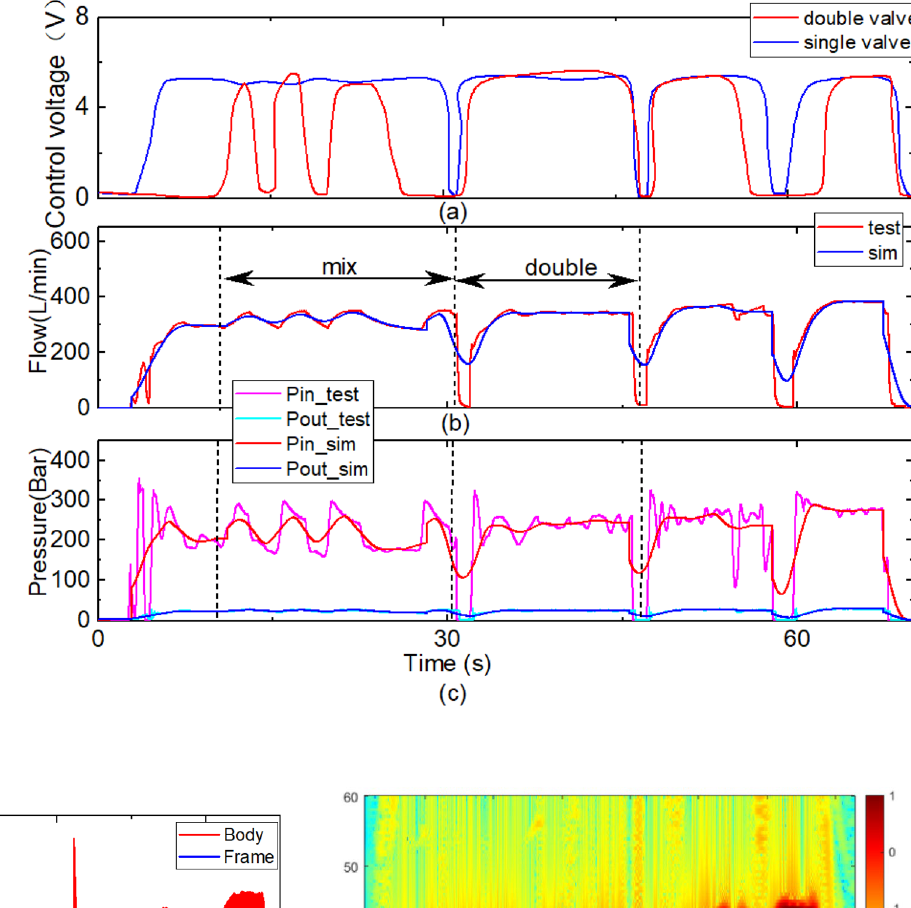
Fig. 9 Comparing results of flow and pressure in operating condition